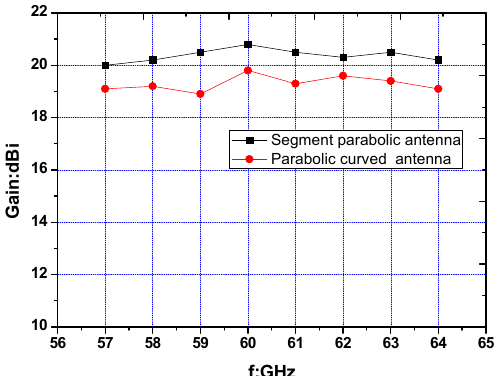
Figure 11. Comparison between Segment parabolic and Parabolic curved antenna.